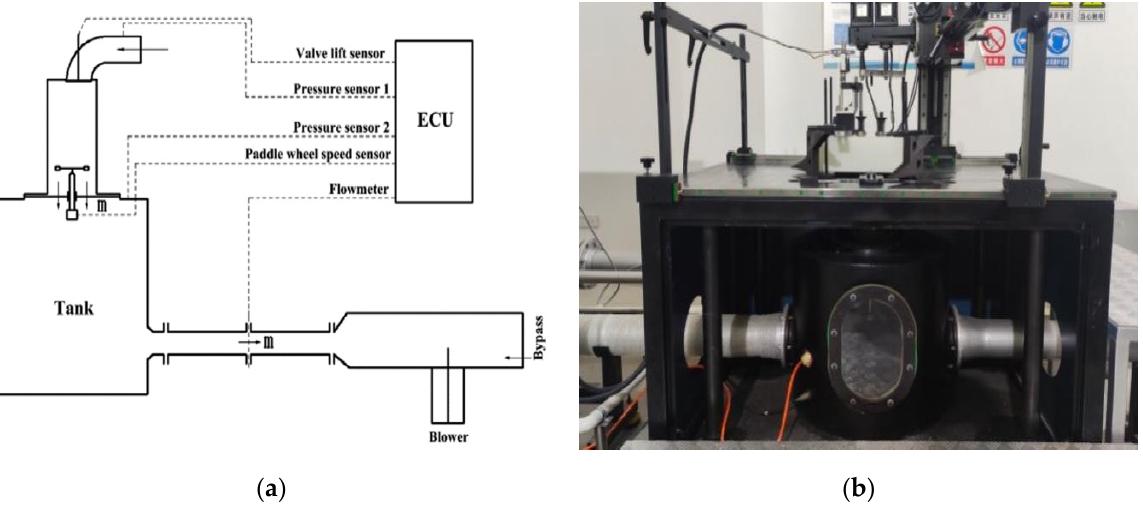
Figure 5. ( a ) Principle diagram of the engine port steady flow test bench; ( b ) physical image of the engine port steady flow test bench.